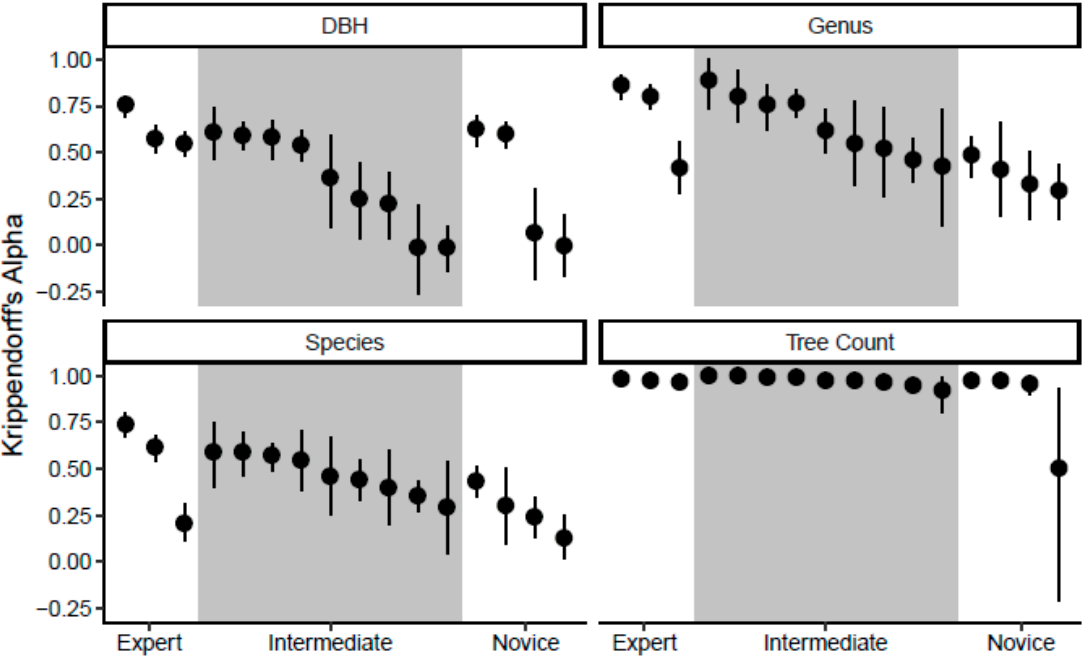
Figure 3. Krippendorff’s alpha scores with 95% confidence intervals characterizing agreement between individual analysts and the field data. Table 3. Diameter at breast height (DBH) classification outcomes by percent, summarized by diameter class and analyst expertise. Agree indicates agreement with the field measurement, Under indicates the percent of observations for which the virtual survey analyst underestimated DBH relative to the field measurement, and Over indicates the percent of observations for which the virtual survey analyst overestimated DBH relative to the field measurement.